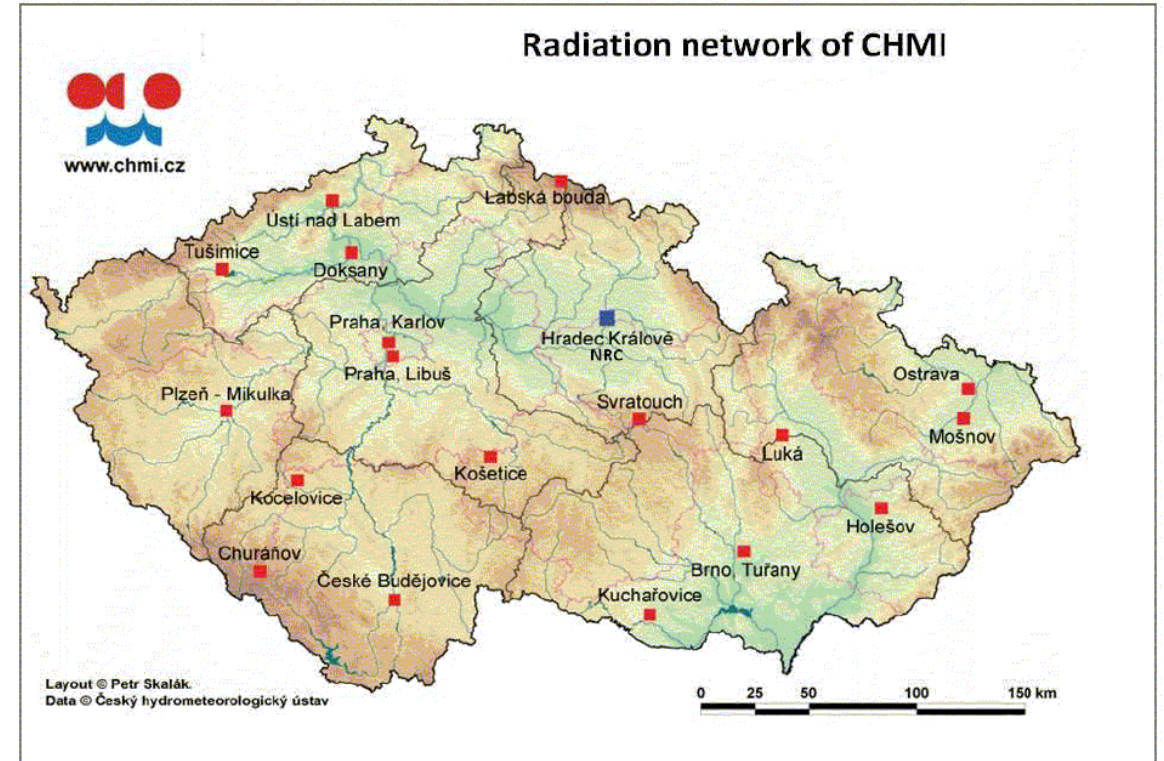
Figure 1. CHMI radiation network stations within the Czech Republic (as of October 2013) (source: